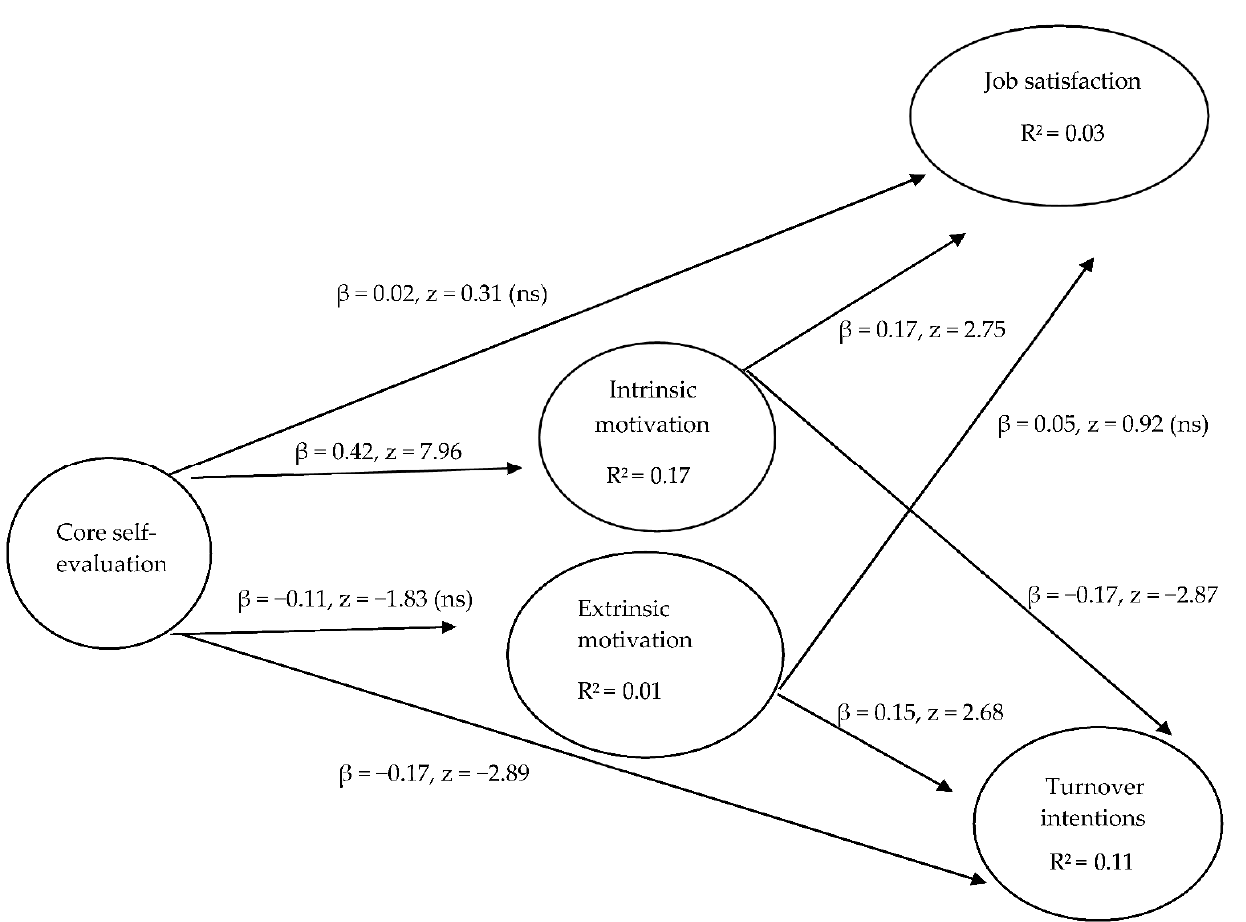
Figure 1. Hypothesized model: Model fit statistics: CMIN/DF = 0.021; CFI = 1.000; RMSEA = 0.000; SRMR = 0.062; GFI = 1.000; AGFI = 1.000; IFI = 1.019; and TLI = 1.101 . Notes: All path estimates are significant except the direct path from core self-evaluations to job satisfaction and extrinsic motivation and the path from extrinsic motivation to job satisfaction. Not significant = ns; CMIN (Minimum discrepancy); CFI (Comparative fit index); RMSEA (Root mean square error of approximation); SRMR (Standardized root mean square residual); GFI (Goodness of fit); AGFI (Adjusted goodness of fit statistics); IFI (Incremental fit index); TLI (Tucker Lewis index).